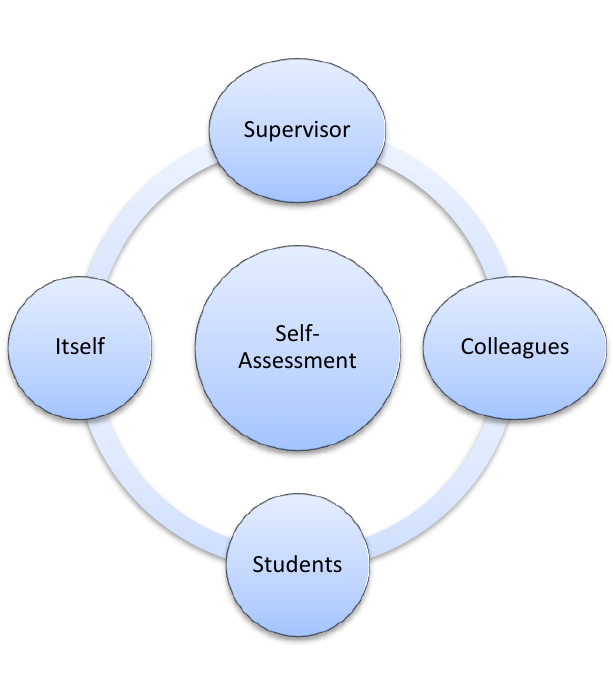
Fig. 2. The 360-degree assessment (Shaout & Yousif, 2014, p.